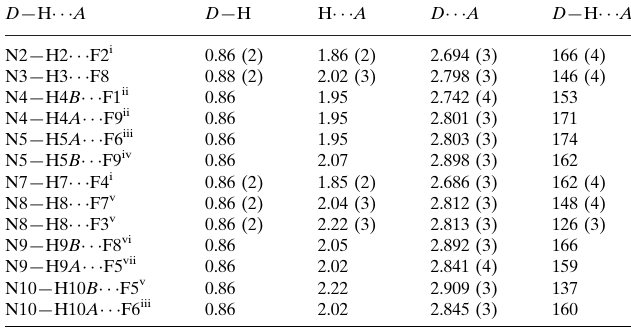
Hydrogen-bond geometry (A˚ , (cid:4) ). D —H (cid:3)(cid:3)(cid:3)